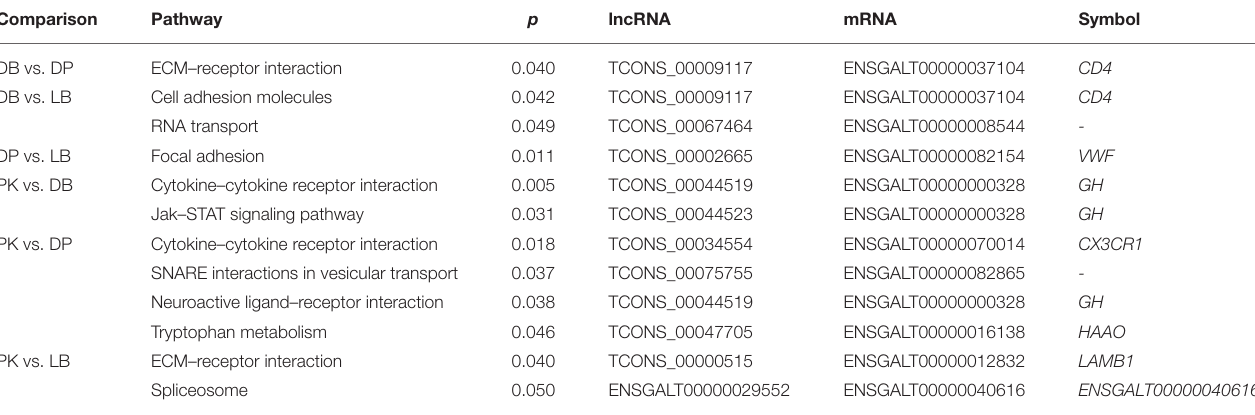
TABLE 2 | Differently enriched KEGG pathways with targeted genes of lncRNA and mRNA of comparisons between chickens with different eggshell colors. Comparison